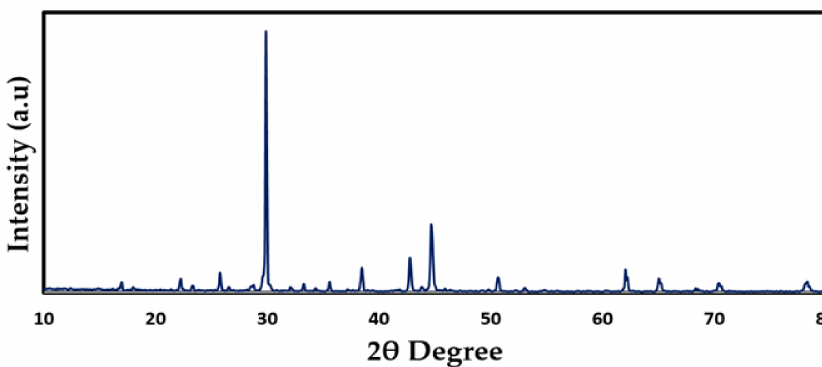
Figure 5. XRD pattern of pure NaBr.